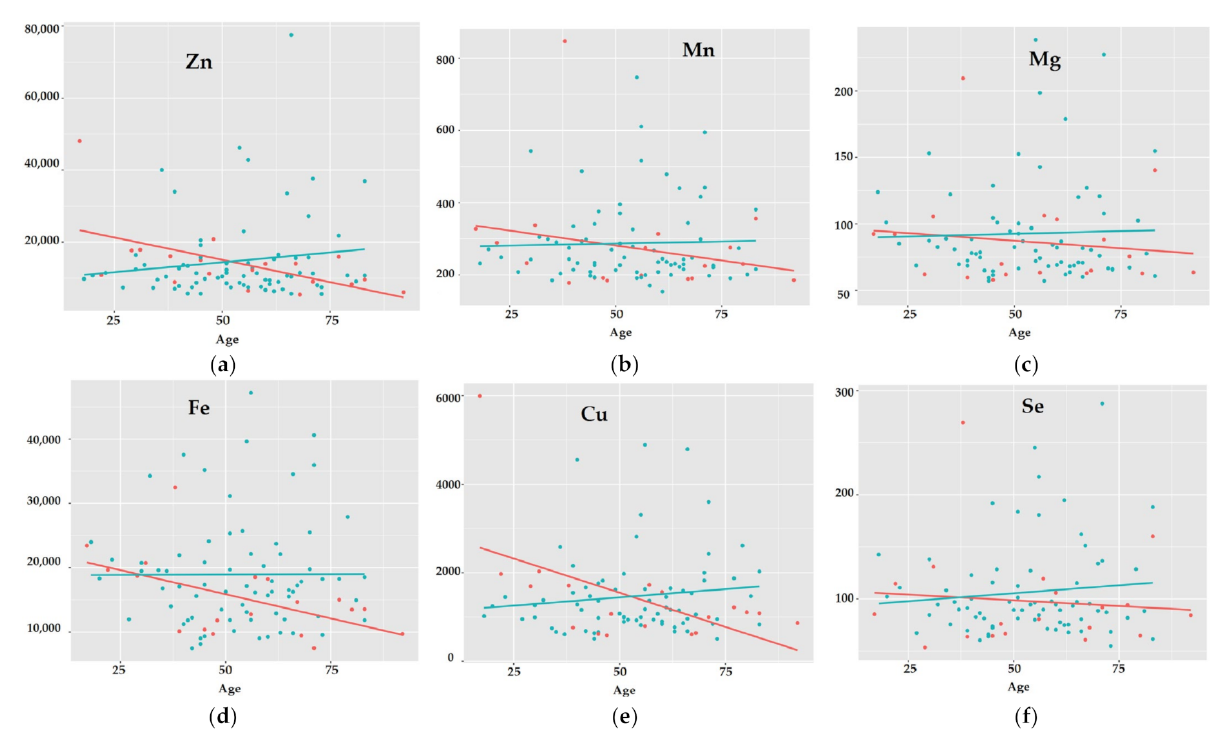
Figure 7. The trends of changes occurring in the concentration of elements (ppb): Zn ( a ), Mn ( b ), Mg ( c ), Fe ( d ), Cu ( e ), Se ( f ) in the optic chiasm with age for males (green points, green line) and females (red points, red